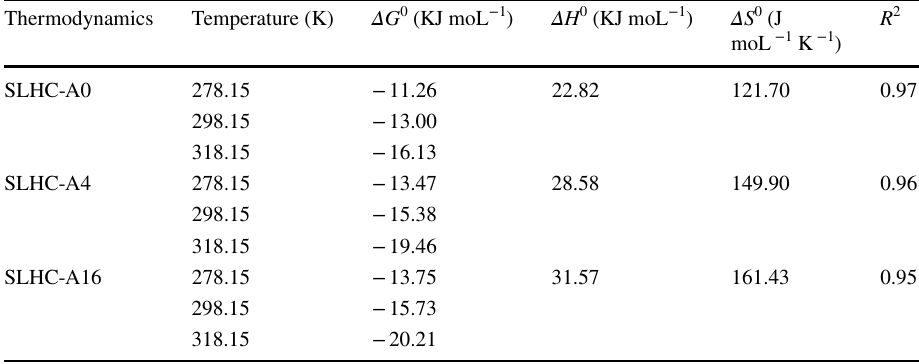
Table 6 Thermodynamic parameters of Cd 2+ to fresh and aged sludge-derived hydrochars